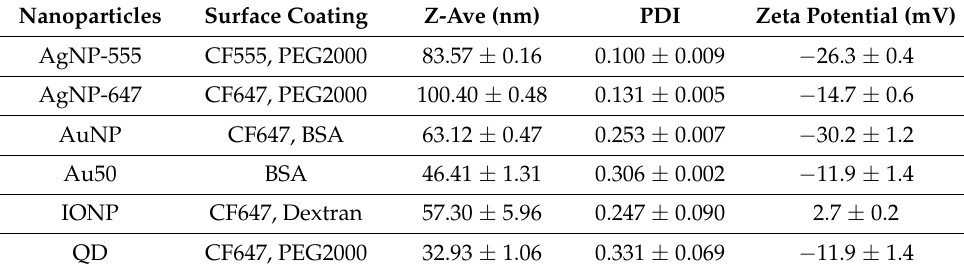
Table 2. Characterization of nanoparticles in this study.